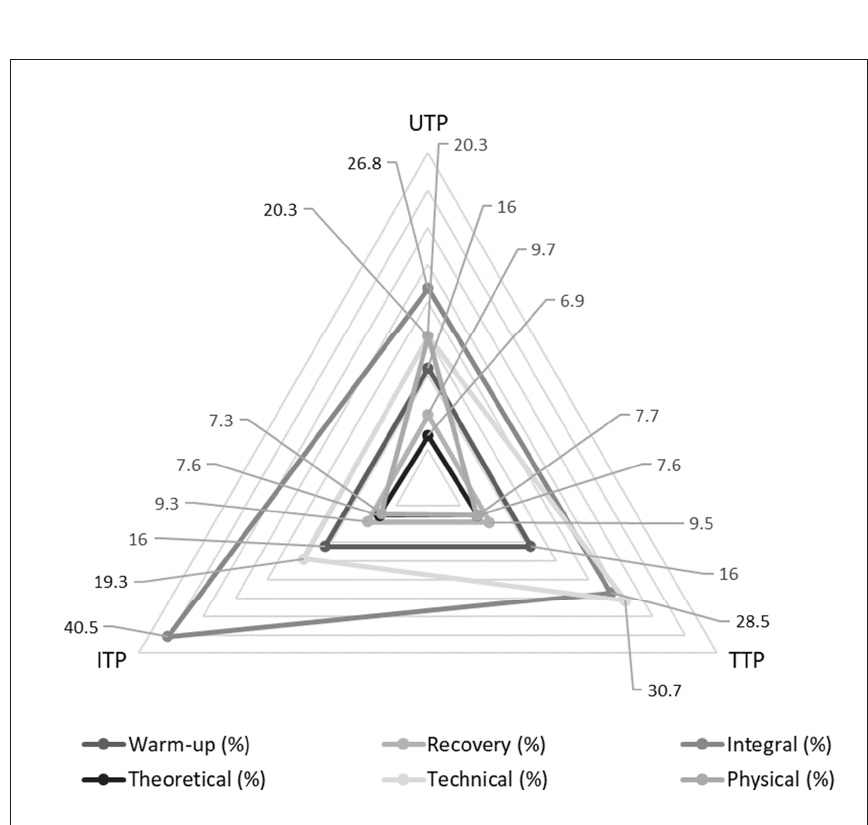
1 Figure. Distribution of different types of preparation in different training programs